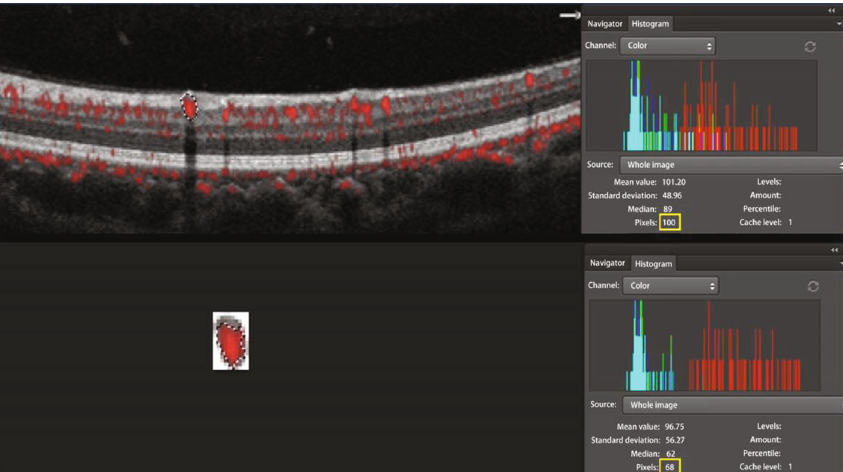
Figure 1: The measurement of fl ow proportion. MA area and fl ow area were measured using a Photoshop program. Every MA area in OCT B-scan with fl ow overlay was dragged using the Photoshop dragging tool and a tablet pen. The histogram of every dragged image was examined and the pixel value of each dragged area was obtained. After that, the selected MA area was cropped out using the Photoshop cropping tool and was pasted to a new image. The fl ow area in the new MA image was also dragged using the Photoshop dragging tool, and the pixel value of each dragged area was calculated in the histogram panel. Flow proportion was de fi ned as the ratio of fl ow area divided by MA area. The fl ow proportion of the MA selected in the fi gure was 68% (68 pixels/100